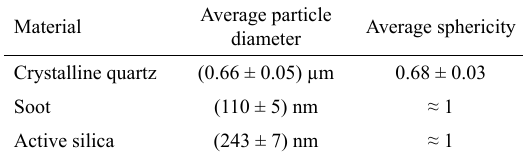
Figure 4. SEM image obtained for crystalline quartz. Table 3. Average diameters and sphericities of analyzed silica